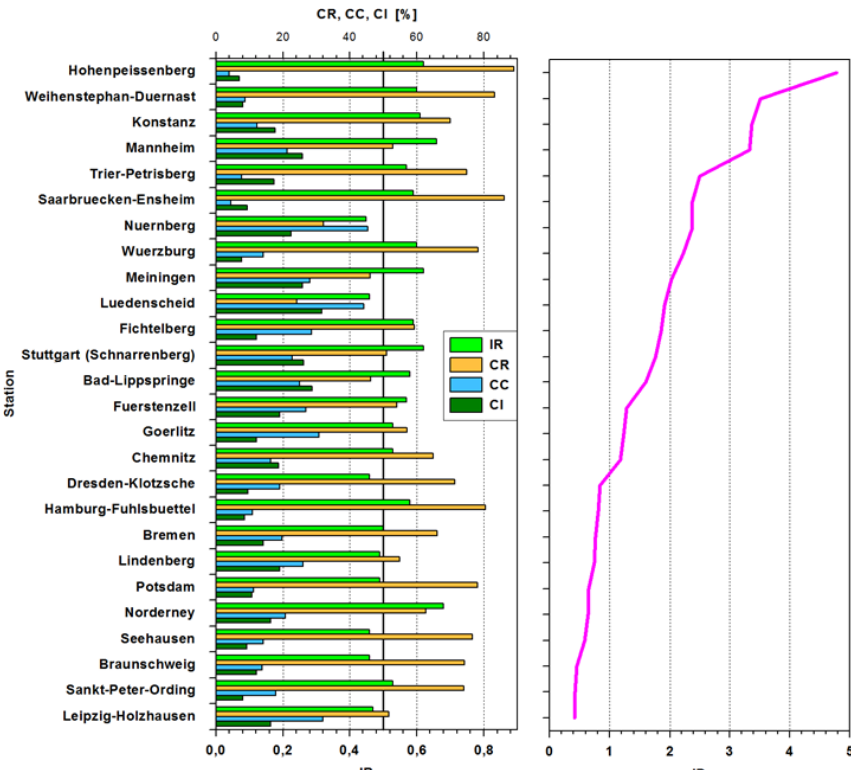
Figure 14. Visualization of the different scores described in Appendix C for all pyranometer stations. The stations are sorted by their ID score with the station with the highest score on